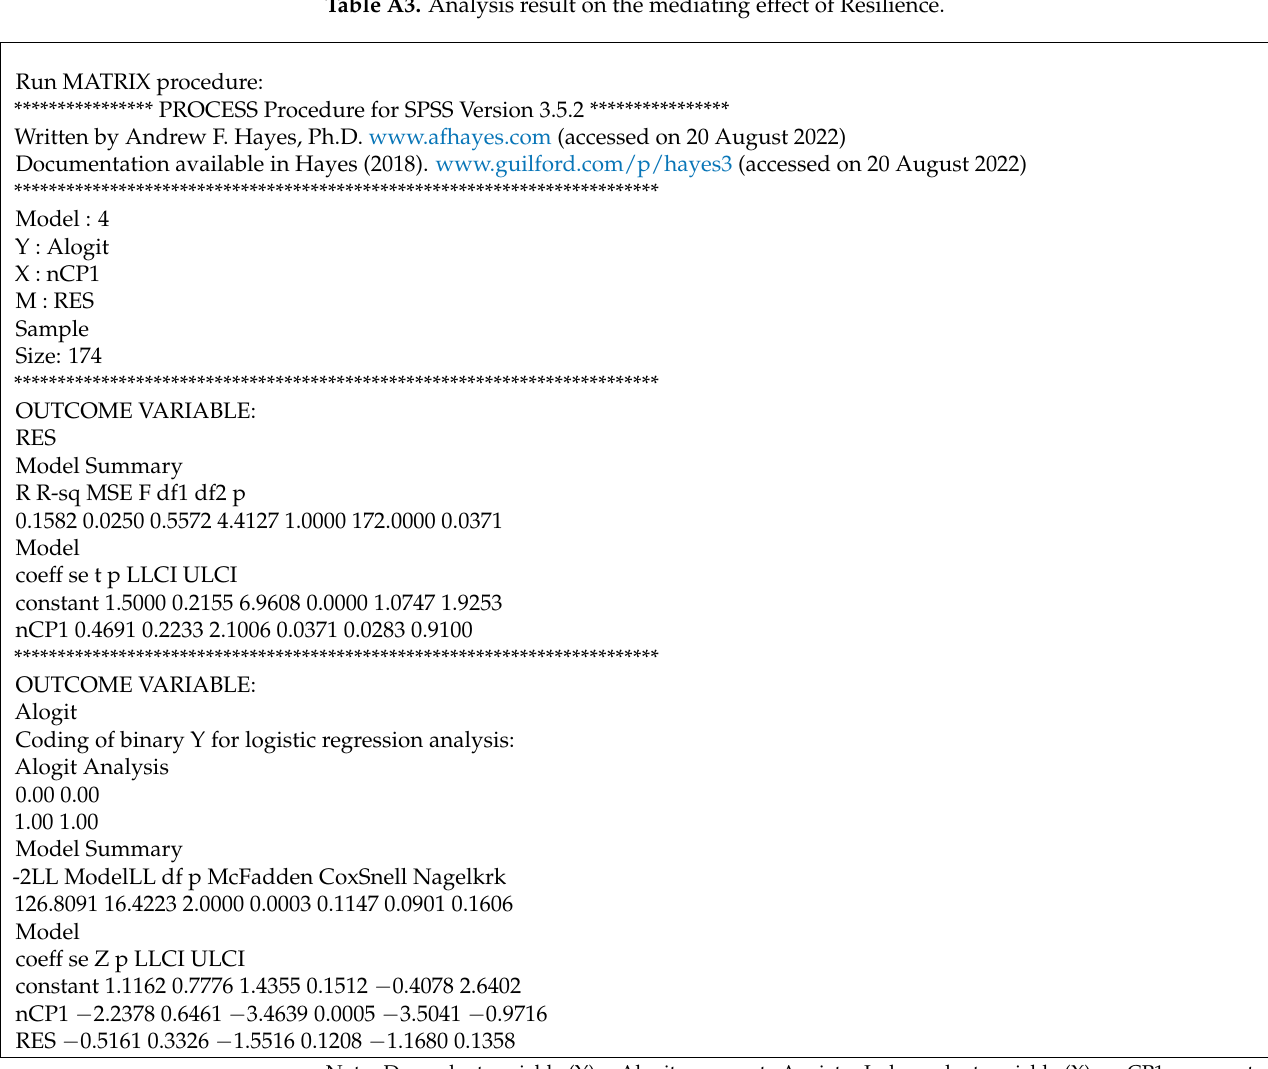
Table A3. Analysis result on the mediating effect of